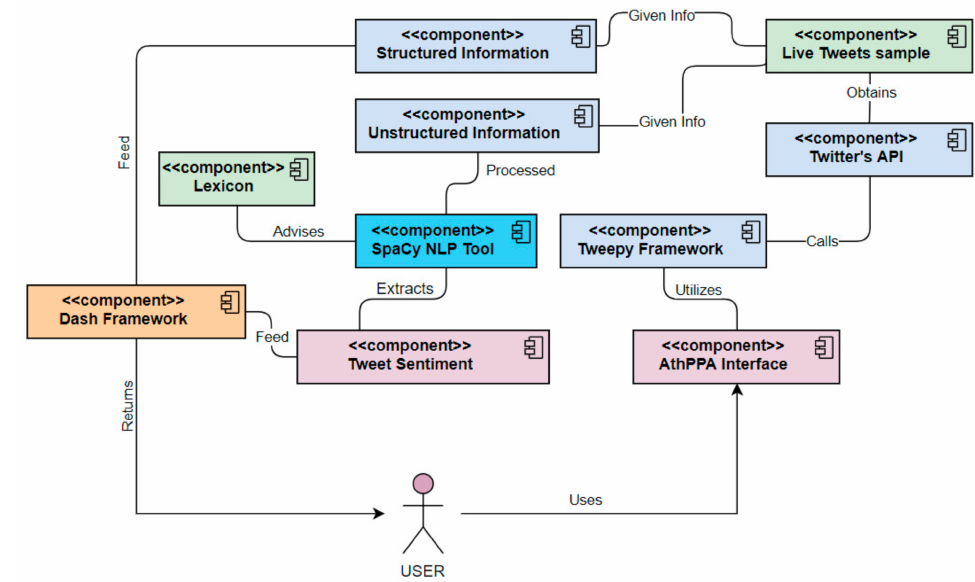
Figure 5. Component diagram of AthPPA.